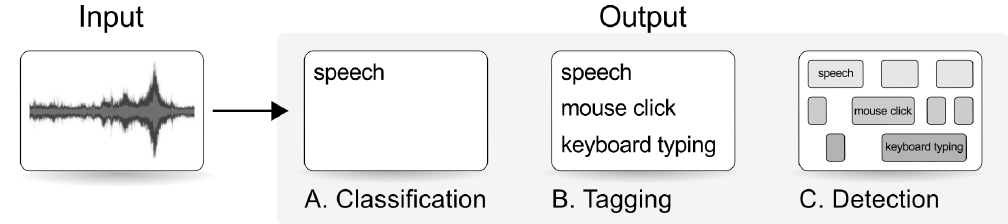
Figure 1. Illustration of sound event classification, tagging and